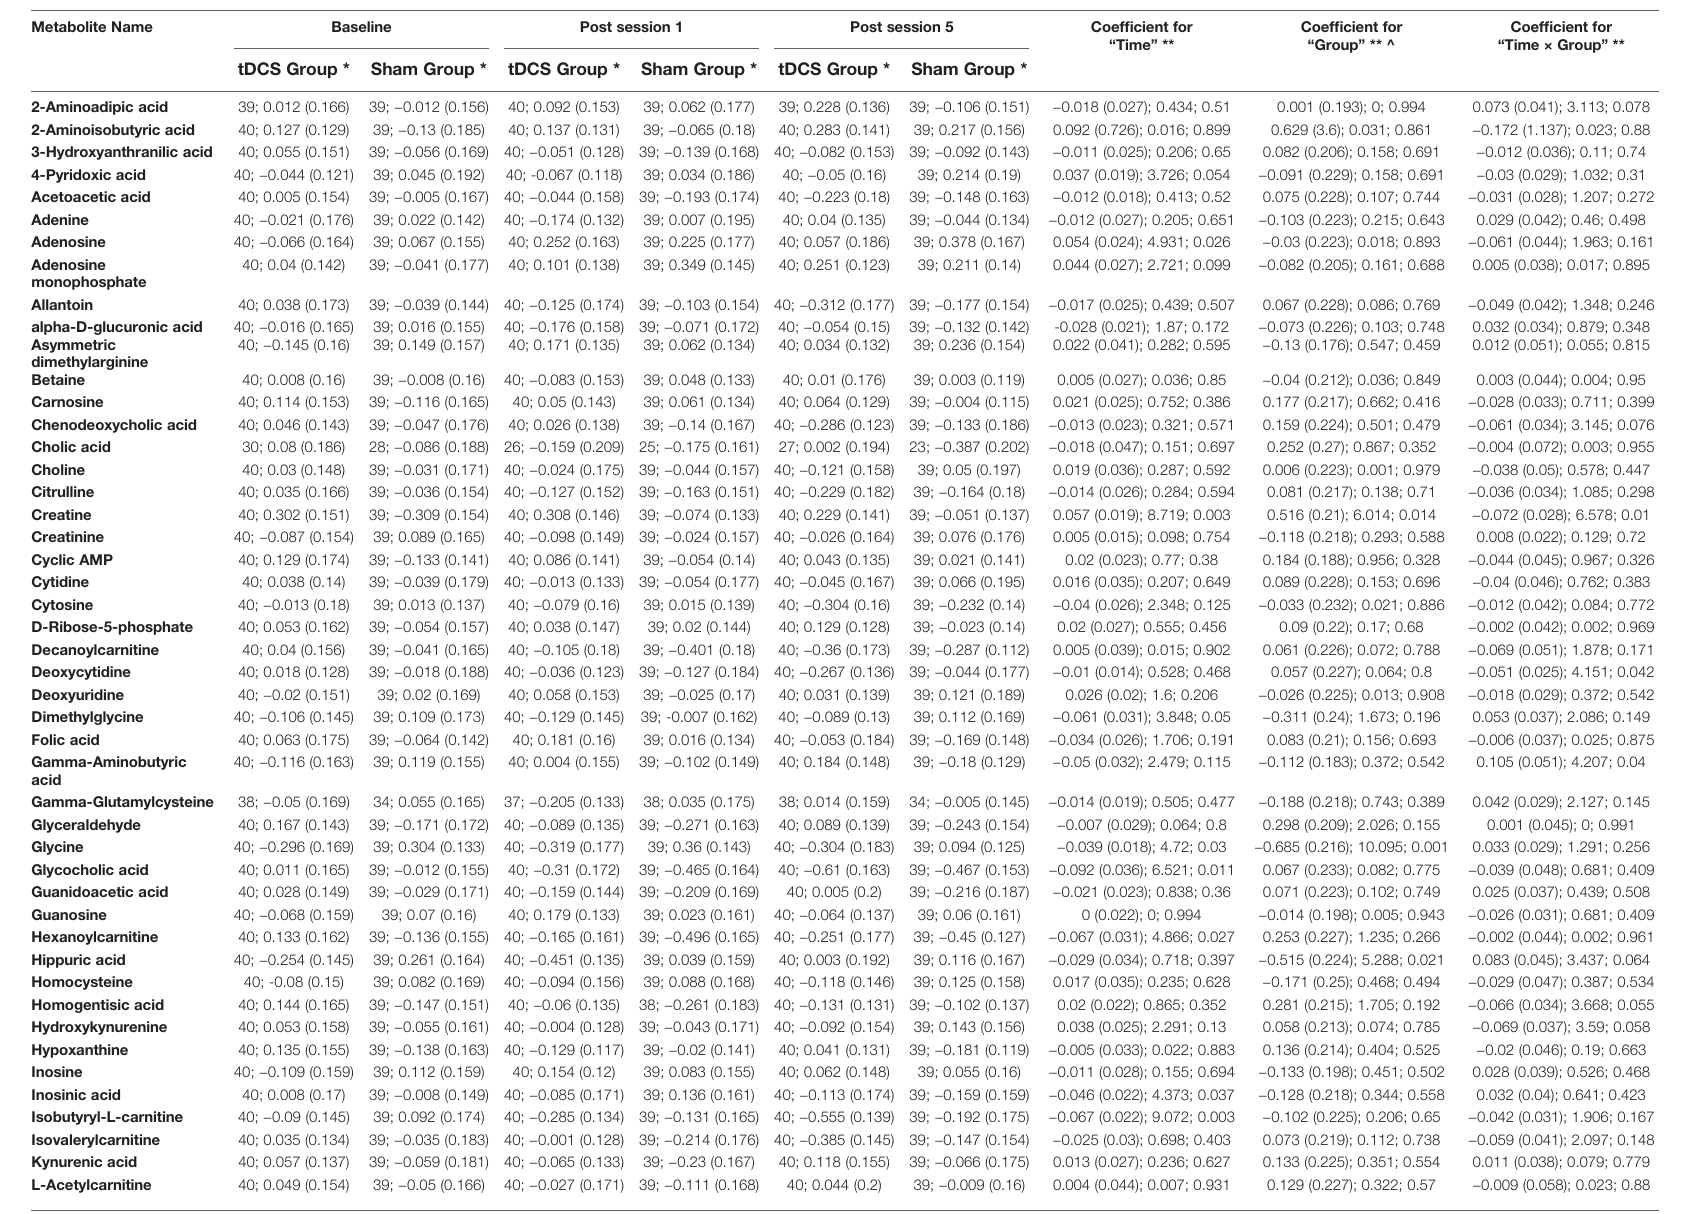
TABLE 1 | Descriptive statistics from the pre-processed data, with main results from the models evaluated for each